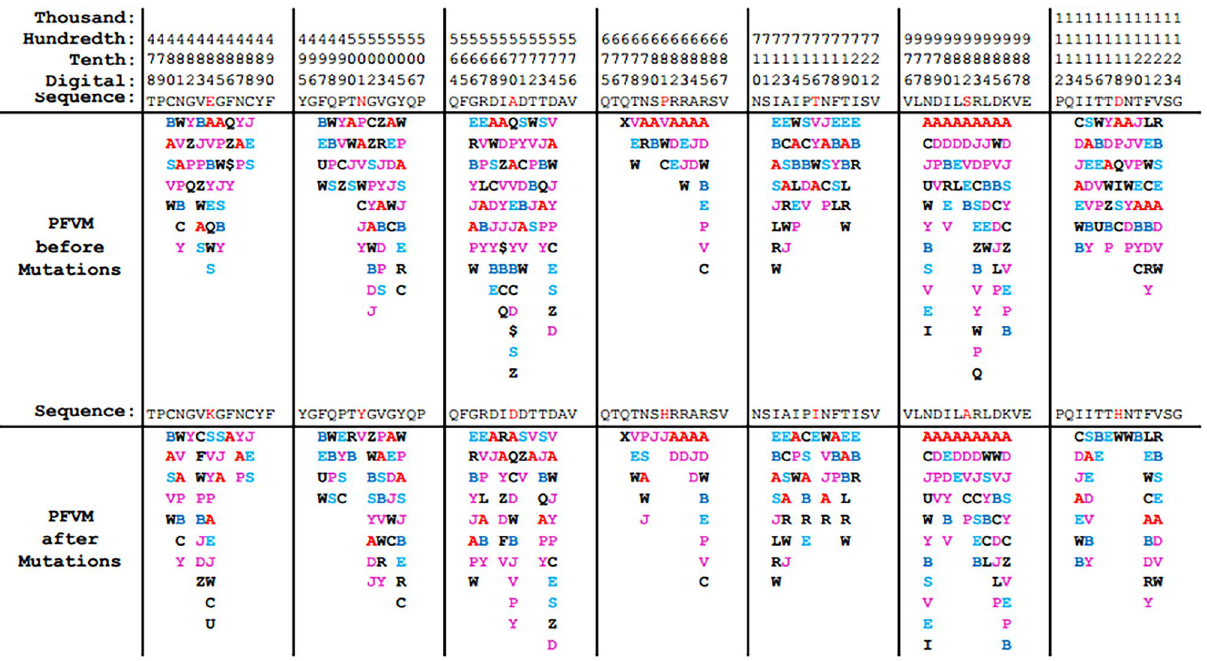
Table 7. Comparison for sections of PFVM between before and after Alpha variant. The PFVM on top is for GenBank QTJ15692.1, and the PFVM on bottom is for the Alpha variant (E484K, N501Y, A570D, P681H, T716I, S982A and D1118H). The rule for the residue position is at the top, the sequences are listed above the PFVM, and the mutated residues are shown in red. In PFVM, the PFSC letters in each column represent the folding variations of 5 continue amino acid residues, and the most favored folding shapes are on